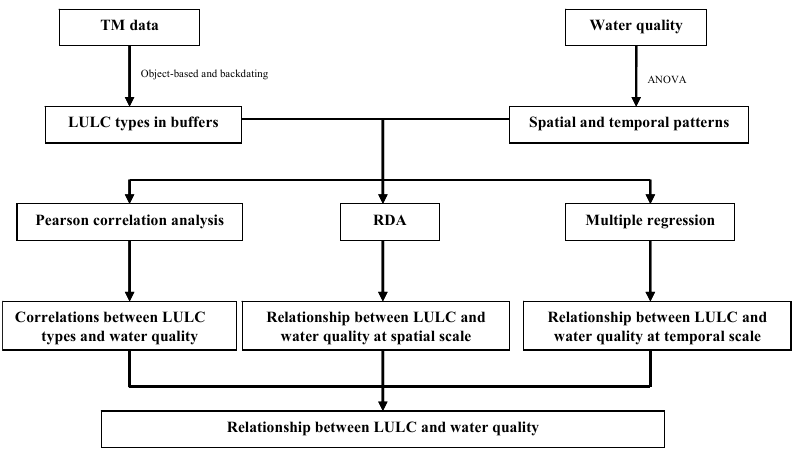
Figure 3. Framework of the methods used for analysis the relationships of LULC and water quality.